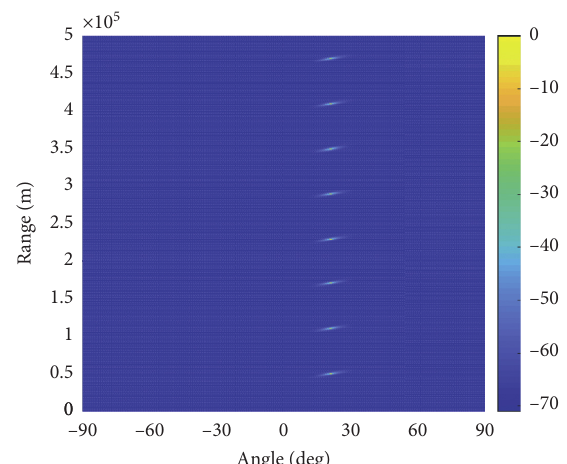
Figure 3: MUSIC spectrum with Δ f